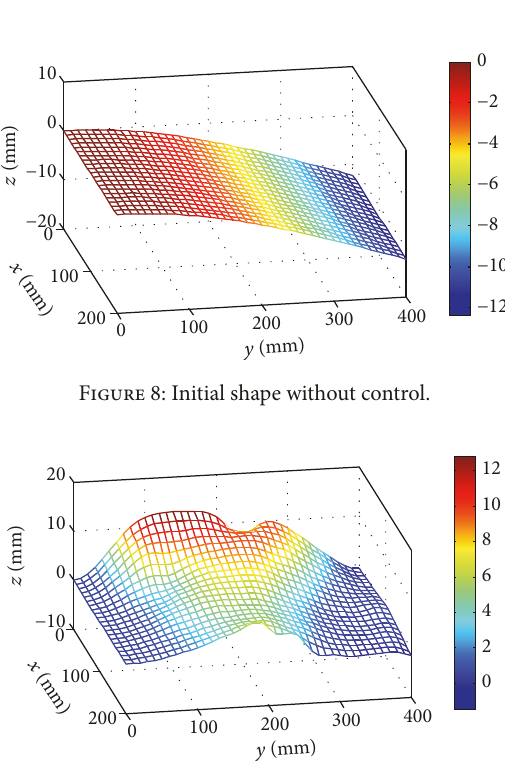
Figure 7: Configuration diagrams of piezoelectric actuators at different generations: (a) 40 generations; (b) 125 generations; (c) 200 generations; (d) 1000 generations.